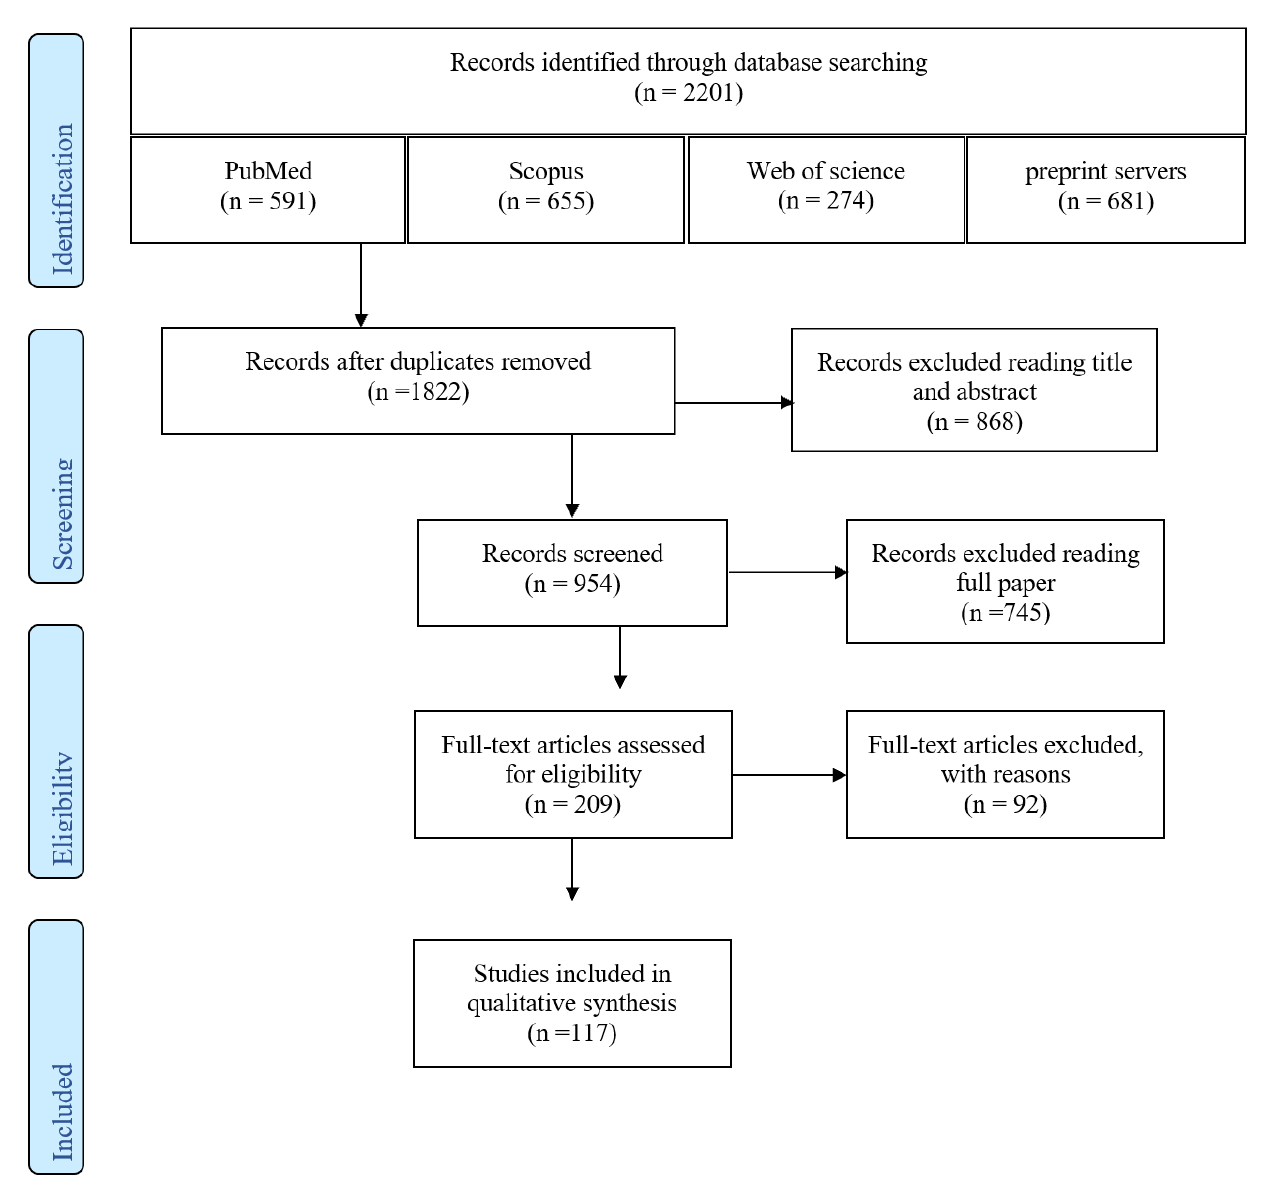
Figure 1. Flow diagram for the selection process of identified articles.